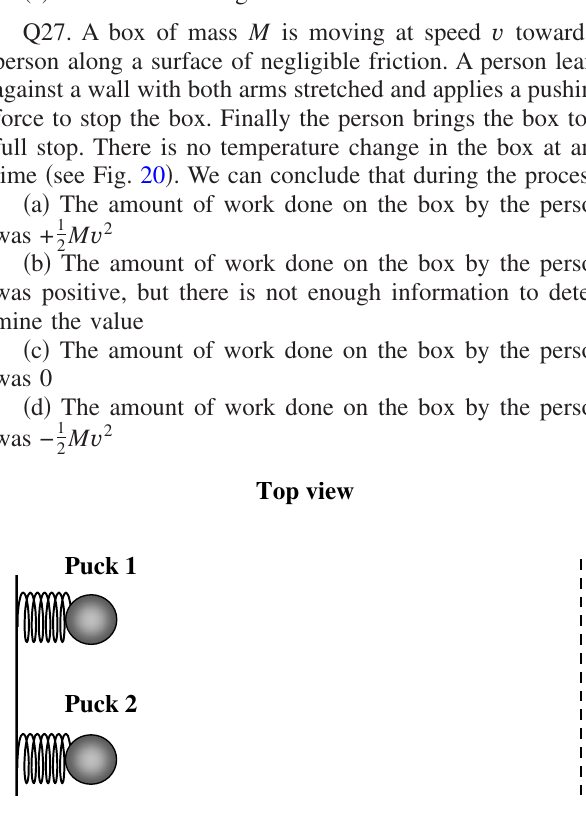
FIG. 22. Diagram of a low-friction table with two pucks launched by pushing them against two identical